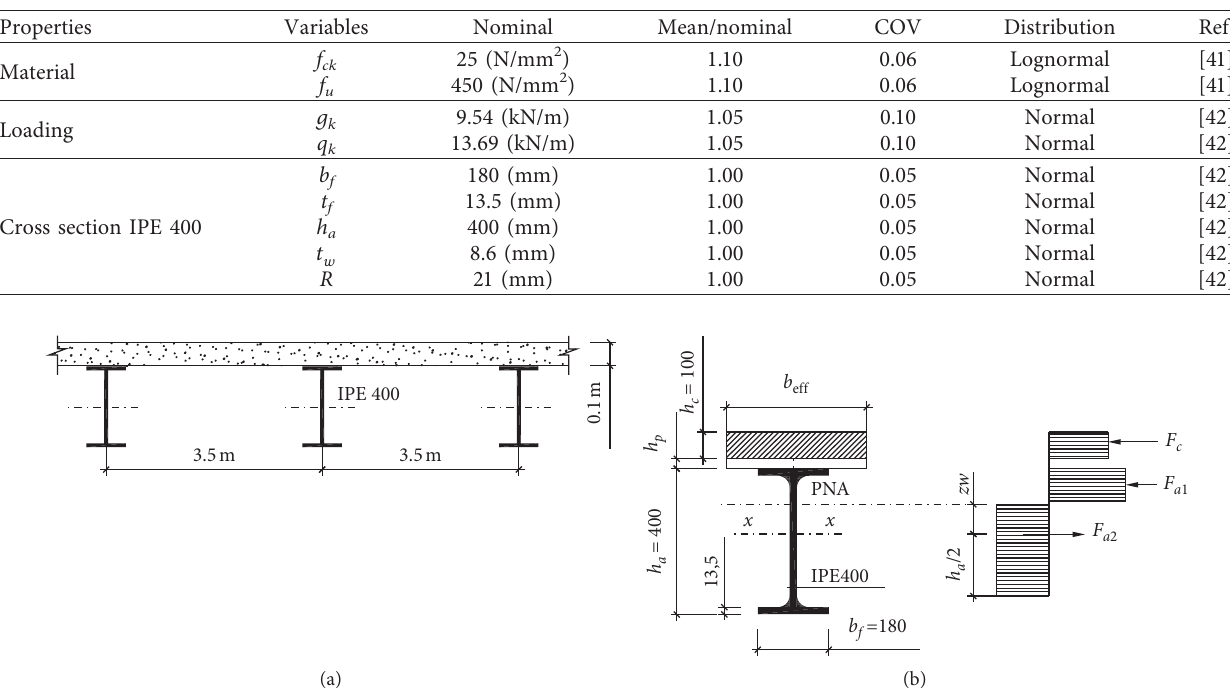
Figure 7: Cross section of slabs (a) and stress distribution of the cross section